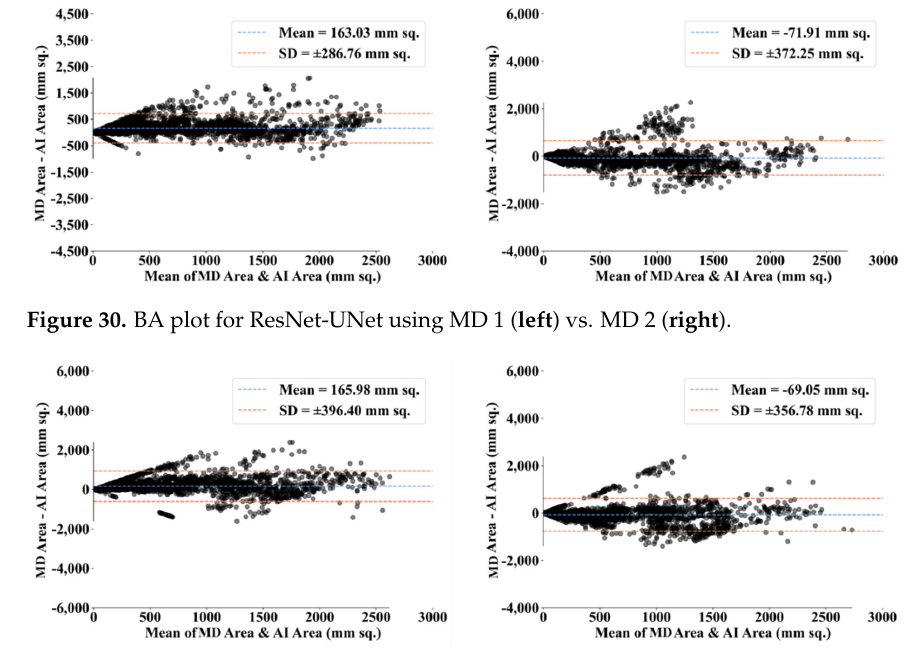
Figure 31. BA plot for MedSeg using MD 1 (left) vs. MD 2 (right).